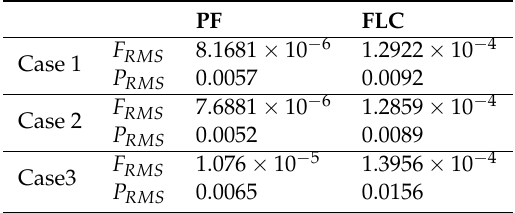
Table 3. RMS values of frequency deviation and supply error for PF and